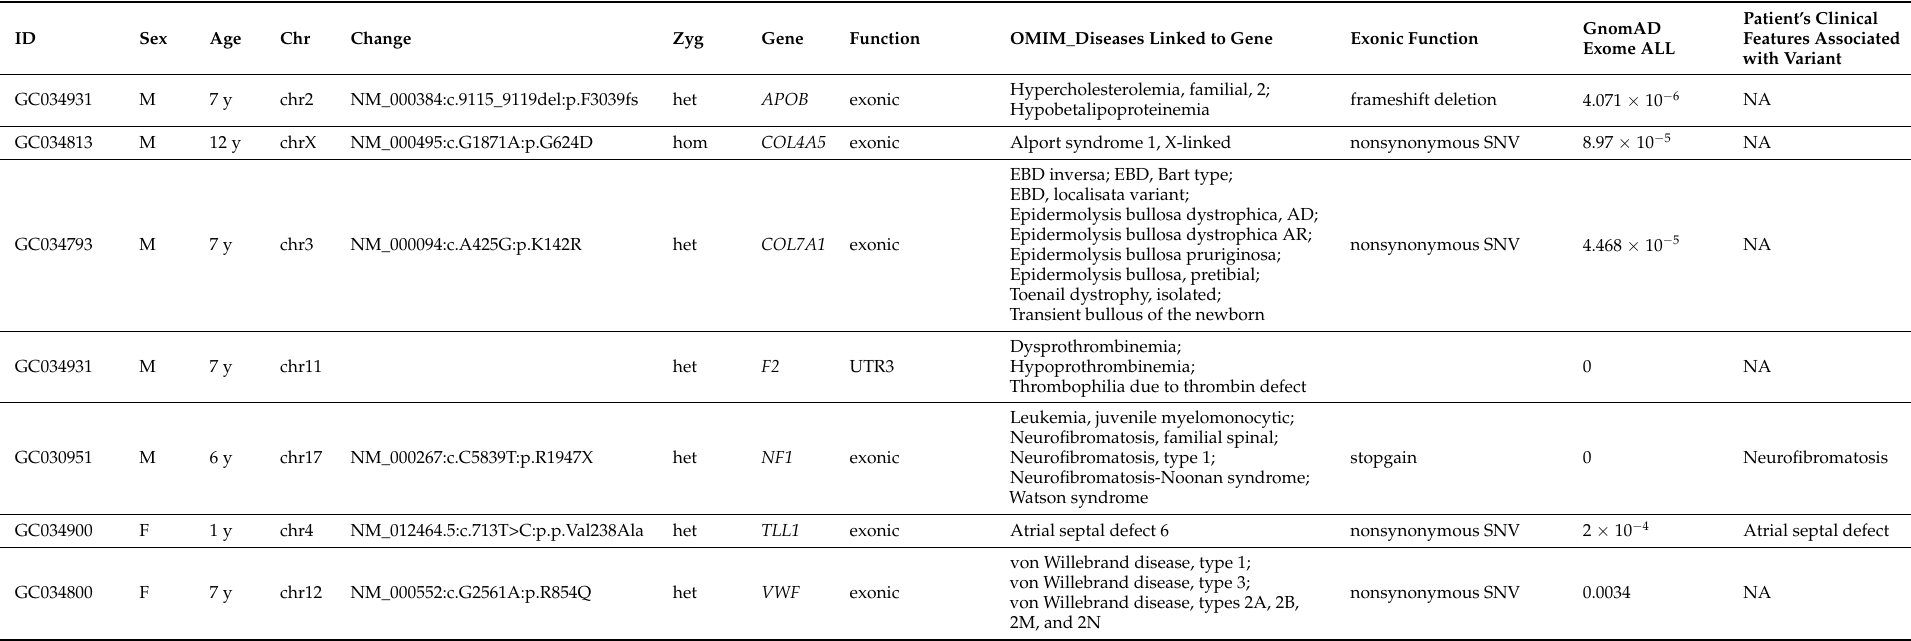
Table 2. Pathogenic and likely pathogenic SNVs, of autosomal dominant inheritance, were selected using filtering with an allele frequency less than 0.001 in